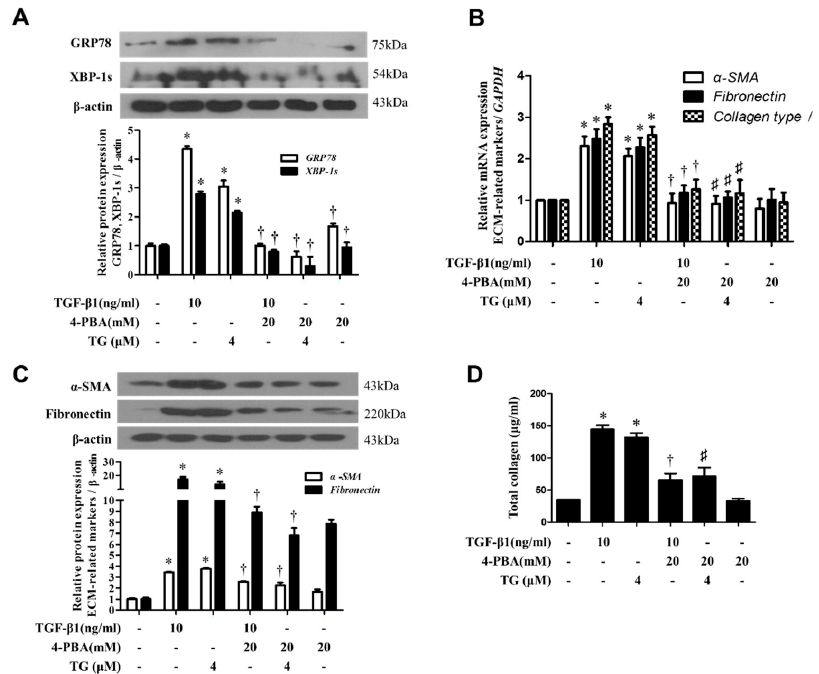
Figure 7. 4-PBA reduces TGF- β 1-induced ER-stress, myofibroblast differentiation and extracellular matrix production in ex vivo organ cultures. Inferior turbinate tissues were cultured and pre-treated with 4-PBA (20 mM) and stimulated with TGF- β 1 (10 ng / mL) or TG (4 µ M) for 24 or 72 h. Cells or tissues treated with TG (4 µ M) were used as a positive control. ( A - C ) The protein and mRNA levels of ER-stress and ECM components were measured by Western blotting and real-time PCR. Data were normalized to β -actin and GAPDH levels, respectively. ( D ) Soluble collagen was determined using the Sircol assay. Data are presented as mean ± SEM and are representative of at least three independent experiments. * p < 0.05 vs. control, † p < 0.05 vs. TGF- β 1 treatment, # p < 0.05 vs. TG